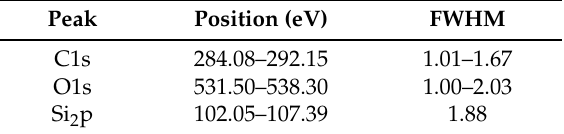
Table 4. XPS features of plasma-modified rayon flock synthetic leather.